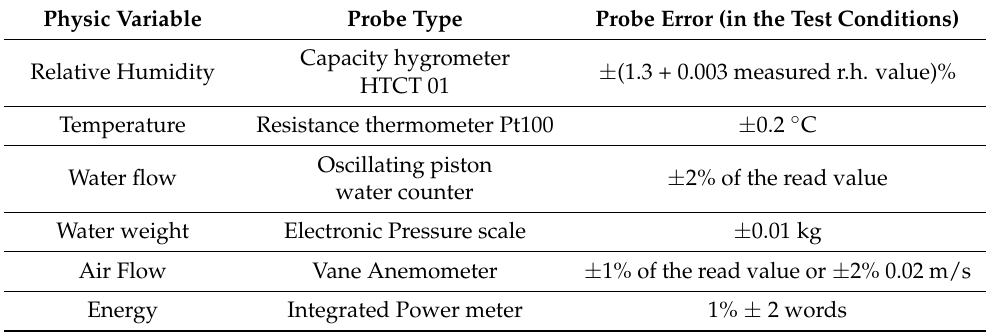
Table 2. Main probes